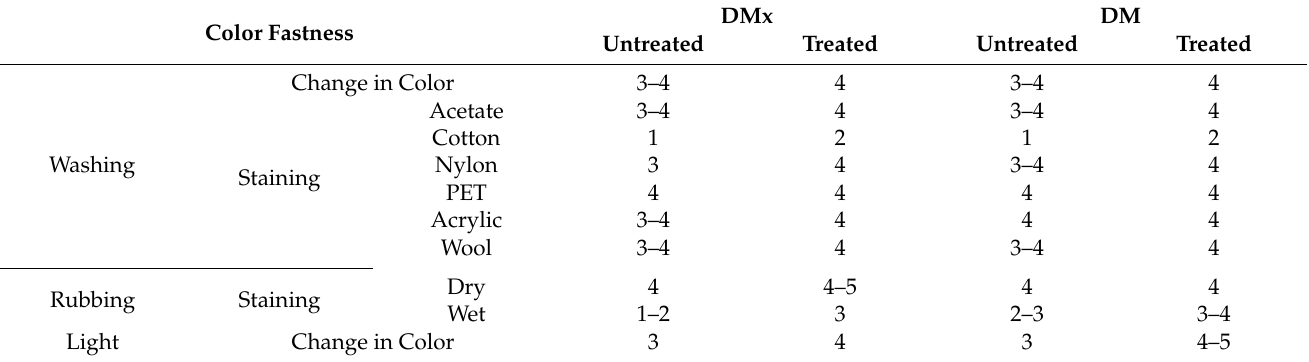
Table 1. Color fastness of untreated and treated textile-based sensors with a polycationic fixing